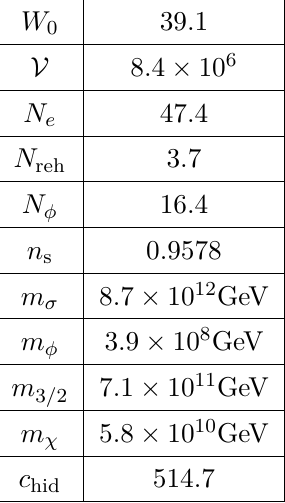
Table 1 . Microscopic parameters W 0 and V , the resulting e-folding numbers, n s , mass scales, and inflaton coupling to hidden degrees of freedom c at a benchmark point that gives the right hid amplitude of the density perturbations and the correct DM abundance. The input parameters are = 12 , and Z = 2 g s = 0 . 1 , Y φ = 0 . 01 , λ = 10 3 , N hid g